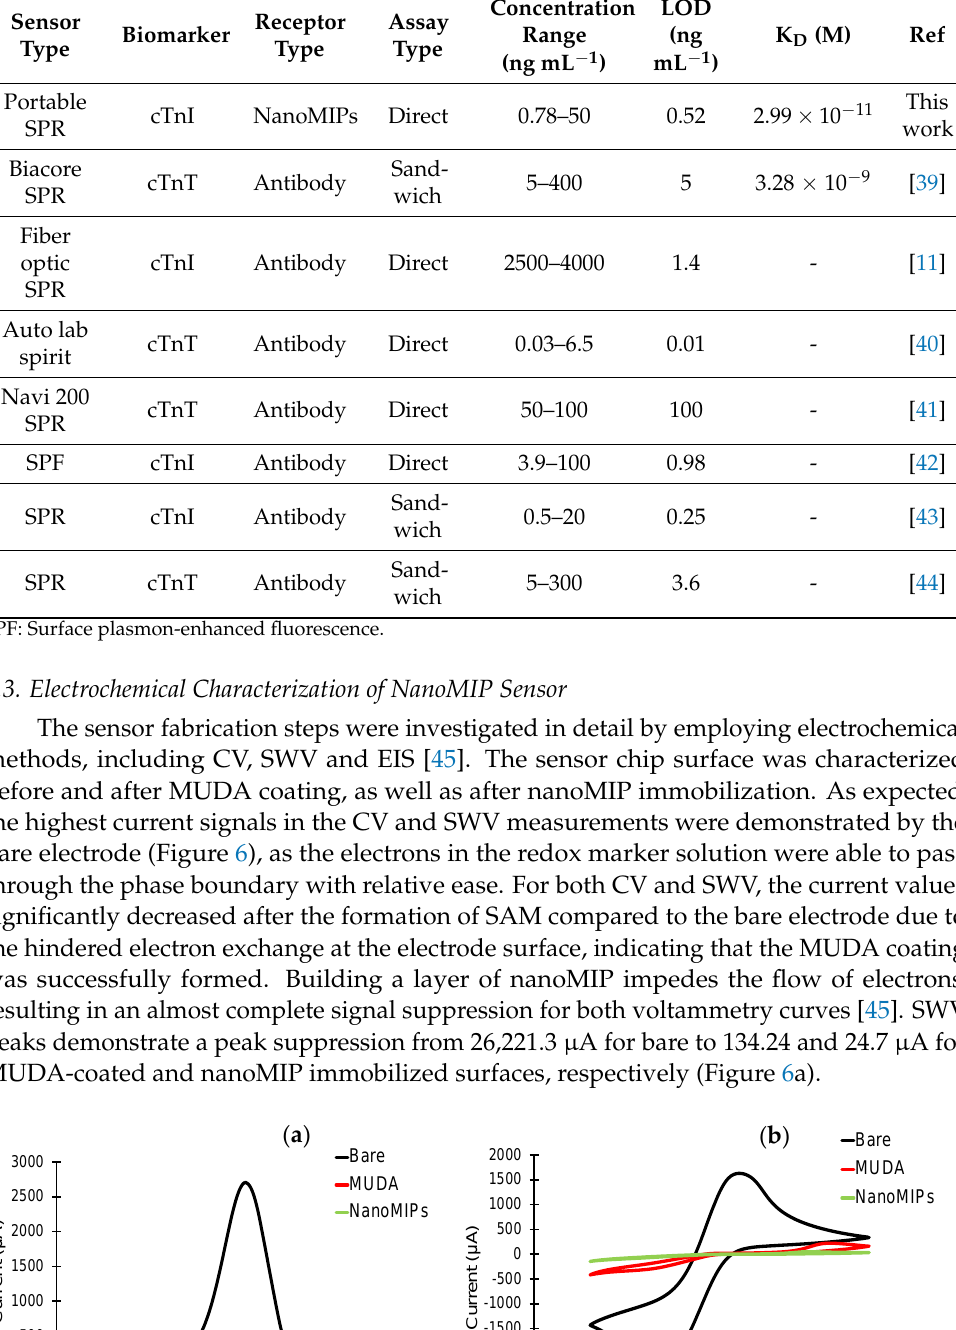
Table 1. The list of various SPR biosensors used for the detection of cardiac biomarkers reported in the literature and the current work.